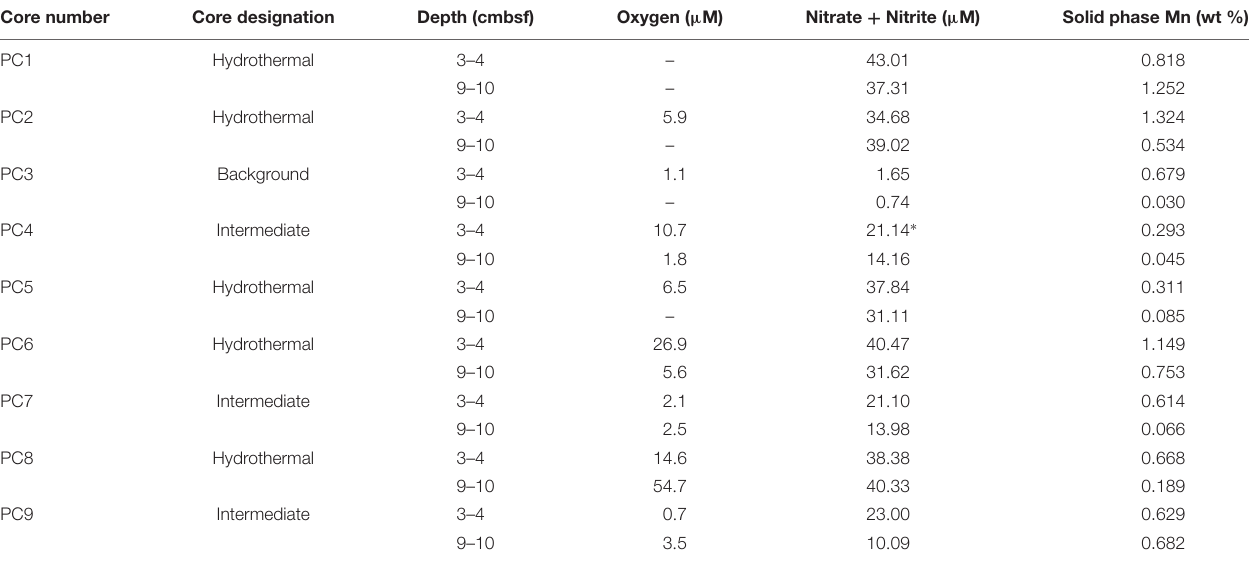
TABLE 1 | Characteristics of sediment samples from on and near Dorado Outcrop that were used for 16S rRNA gene sequencing (see Figure 1 for more